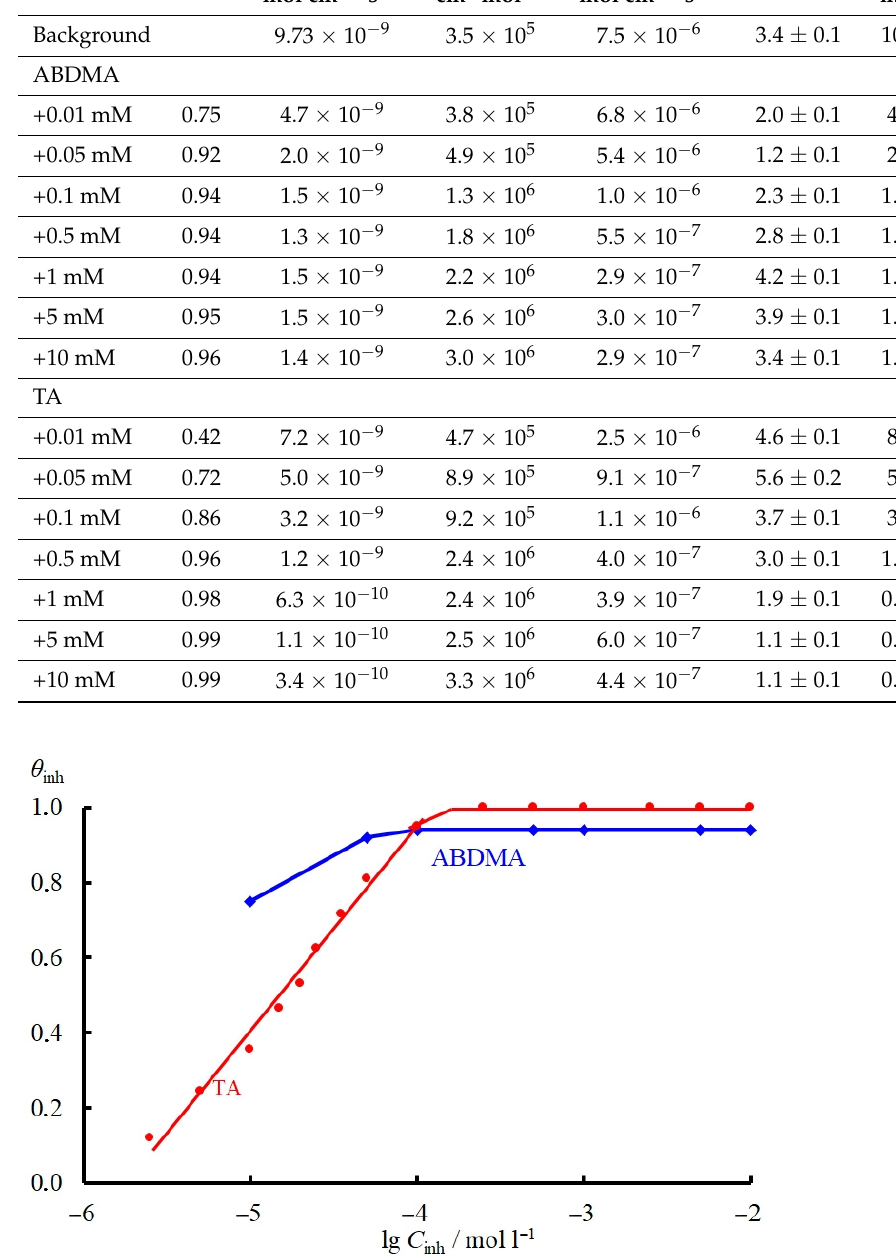
Figure 7. Adsorption isotherm of TA and ABDMA on MS steel (E = 0.30 V) from 2.0 M HCl.